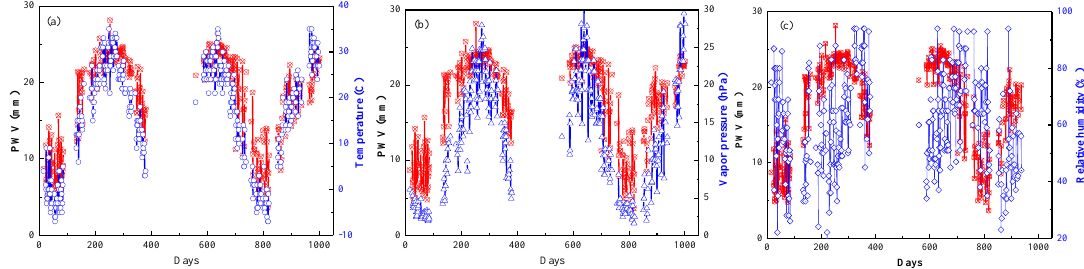
Figure 8. Variations between PWV and atmospheric temperature, vapor pressure and humidity. ( a ) temperature; ( b ) vapor pressure; ( c ) relative humidity.